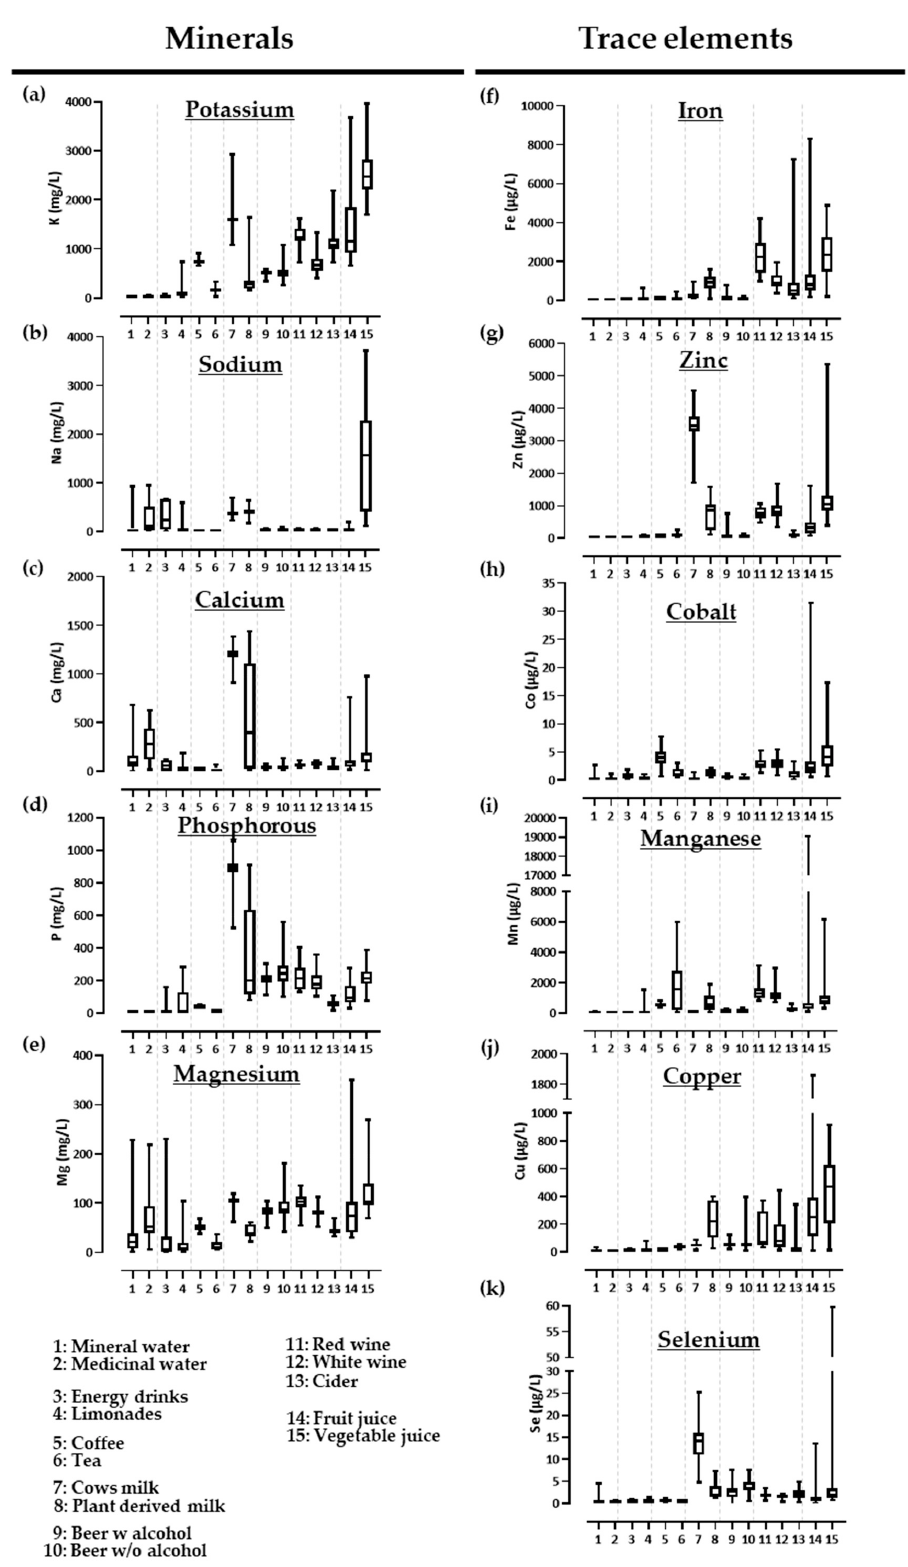
Figure 2. Mineral and trace element concentrations in commercially available beverages in Germany. ( a – e ) Mineral and ( f – k ) trace element concentrations (obtained via ICP-MS analyses) are shown as boxplots for 15 sub-groups of